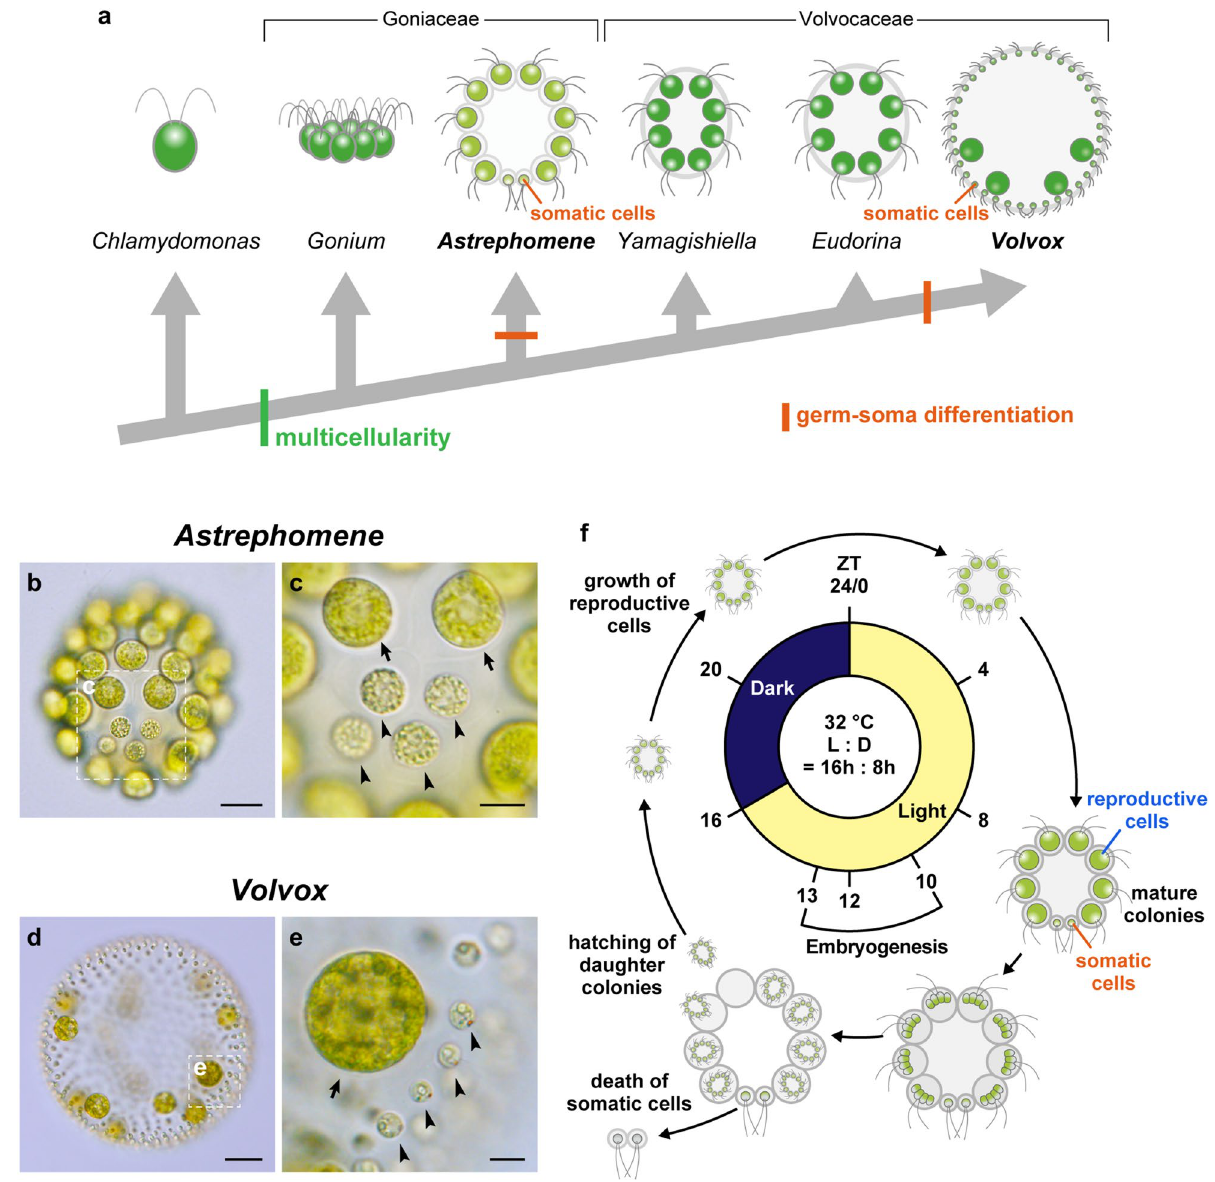
Figure 1. Convergent evolution of germ-soma differentiation in Astrephomene and Volvox . ( a ) Schematic representation of the phylogenetic relationships of the volvocine algae and the parallel evolution of germ- soma differentiation. Volvocine algae include unicellular Chlamydomonas , multicellular Volvox and various intermediate forms and a suitable model for research into the evolution of multicellularity 5 . Germ-soma differentiation are thought to have evolved twice or more independently within this group 24,25 . Astrephomene have acquired somatic cells independently of Volvocaceae. The phylogenetic relationships are based on the present phylogenomic analysis (Supplementary Fig. 4) and a previous report 38 . The genomes of all genera except for Astrephomene have been sequenced in previous studies 7–11 . ( b ) A vegetative colony of Astrephomene gubernaculifera. Scale bar = 20 μm. ( c ) Four posterior somatic cells (arrowheads) in A . gubernaculifera . Compared to reproductive cells (arrows), somatic cells are small and pale colored. Scale bar = 10 μm. ( d ) A vegetative colony of Volvox carteri . Scale bar = 50 μm. ( e ) Somatic cells (arrowheads) and gonidia (reproductive cells, arrow) in V . carteri . While somatic cells are biflagellate, gonidia have no flagella. Scale bar = 10 μm. ( f ) Schematic diagram of the asexual life cycle of A . gubernaculifera in the synchronous culture. The asexual life cycle is completed in approximately 24 h, and the culture is highly synchronized with the light–dark cycle. While reproductive cells undergo cell growth and embryogenesis to form daughter colonies, somatic cells do not undergo obvious growth or embryogenesis and reach cell death. ZT Zeitgeber